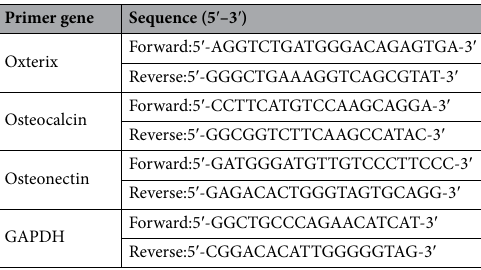
Table 1. Primers used in Real time quantitative PCR.